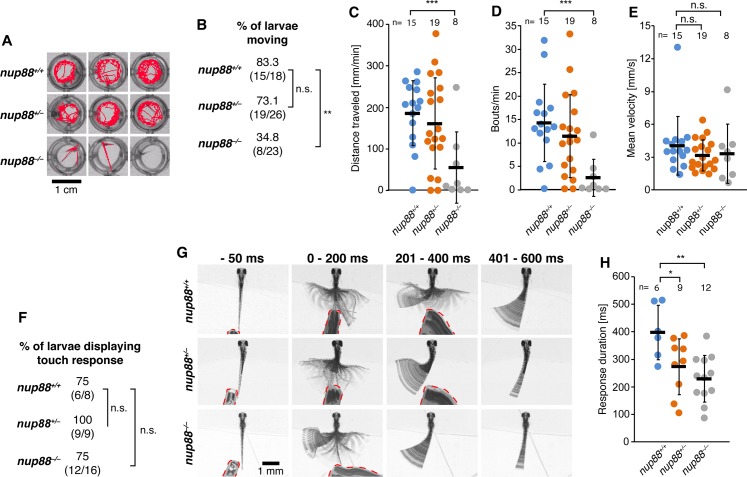
nup88 mutants display motor impairments.(A) Images showing representative examples of motion tracking (red lines) of 4 dpf nup88 homozygous and heterozygous mutants, and wild-type controls during one-minute long spontaneous locomotion recordings. (B) Quantification of percentages of larvae displaying spontaneous movement, also shown as (number of moving larvae/total number of larvae). Beeswarm graphs with individual data points depicting distance travelled/minute (C), bouts/minute (D), and mean velocity of swimming bouts (E) of nup88 mutants and wild-type controls displaying spontaneous locomotion. (F) Quantification of percentages of larvae displaying touch-induced escape response, also shown as (number of responsive larvae/total number of larvae). (G) Representative examples of touch-induced escape behavior of 4 dpf head-restrained nup88 mutant and wild-type larvae. The first column depicts single frames taken 50 ms before an escape response was induced by touching the trunk of larvae with a pipette tip (red dashed lines). The other columns show superimposed frames of escape responses at consecutive time intervals after touch. The asymmetric tail movement displayed in some of the images (nup88+/- and nup88-/- at 201–400 ms, and all genotypes at 401–600 ms) represents slow motion of the tail toward its original position. The escape response terminated before this phase (see also S2–S4 Movies). (H) Graph showing average durations of escape response in nup88 mutants and wild-types. * p < 0.05, ** p < 0.004, *** p = 0.001, n.s. = non-significant, two-tailed Fisher exact test (B and G) or two-tailed t-test (C-E, H). Data in C-E and H are shown as mean ± SD. n is number of embryos/larvae analyzed.